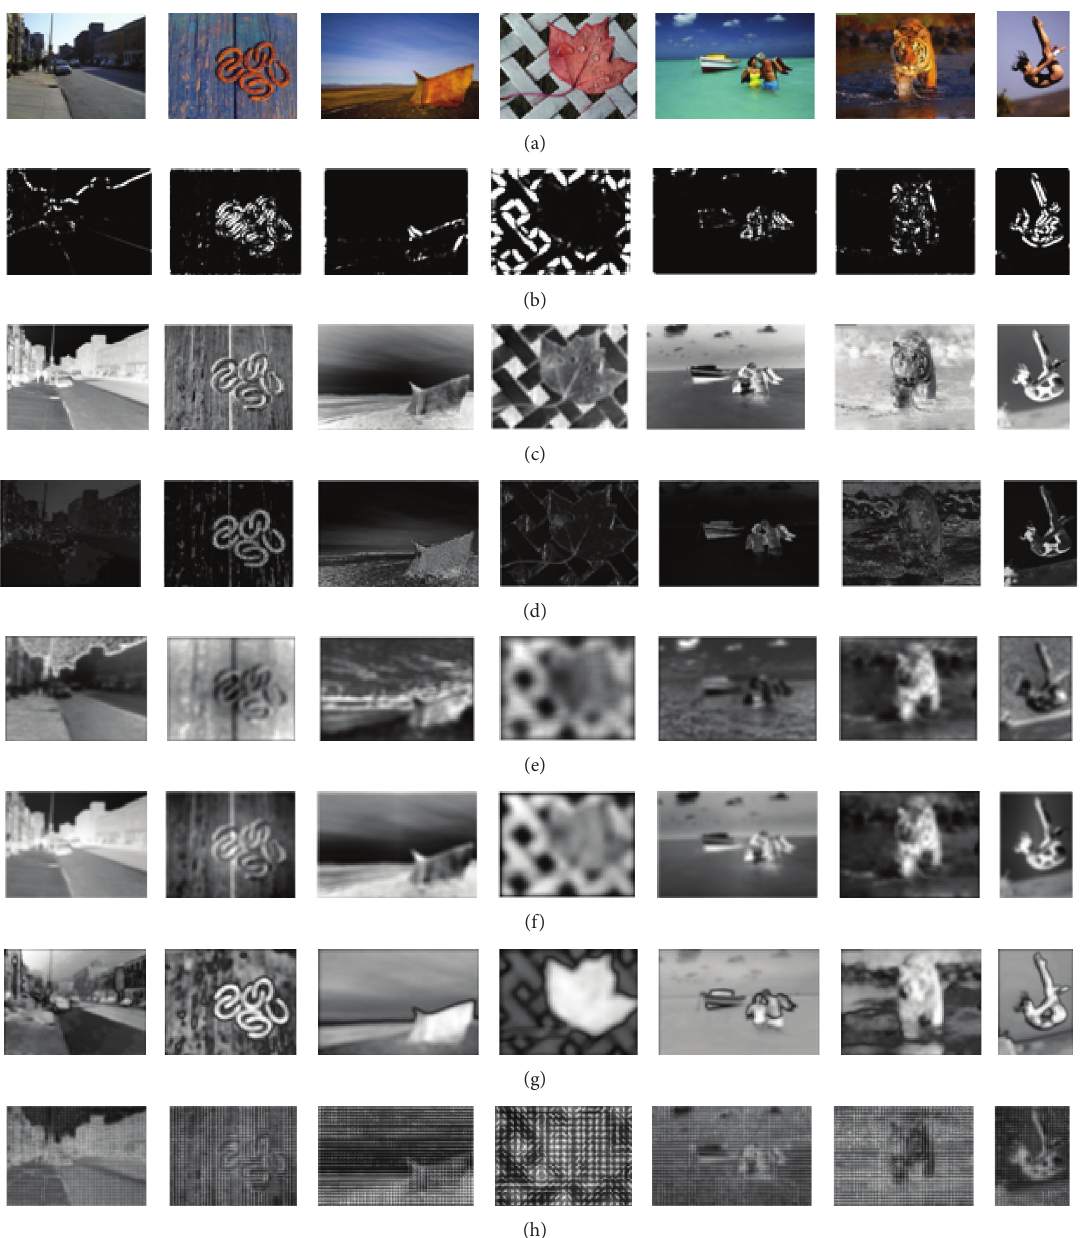
Figure 19: Comparative analysis for static images: (a) original image, (b) gradient saliency by utilizing Sobel operator, (c) modified frequency tuned spatial model II, (d) integrating colour saliency with texture feature (local binary pattern (LBP)), (e) modified frequency tuned spatial model I, (f) visual saliency based on colour image (colour saliency [38]), and (h) integrating modified frequency tuned spatial model I with histogram of oriented gradient (HOG) [48]. Table 3: Comparison of accuracy of proposed